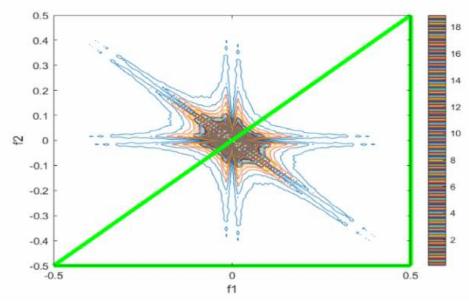
Figure 4. Schematic of selected area for feature